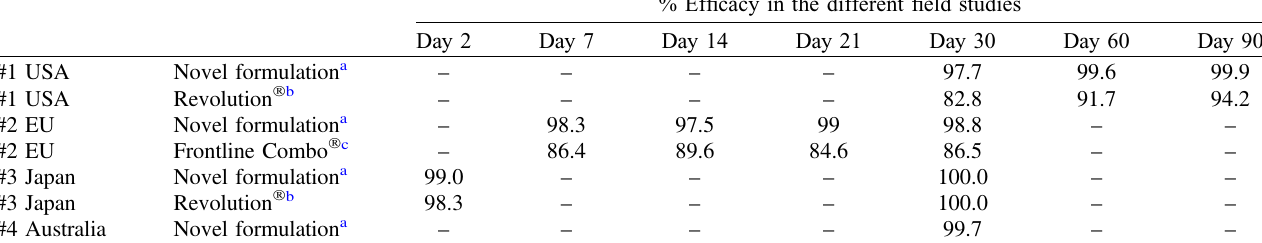
Table 3. Ef fi cacy